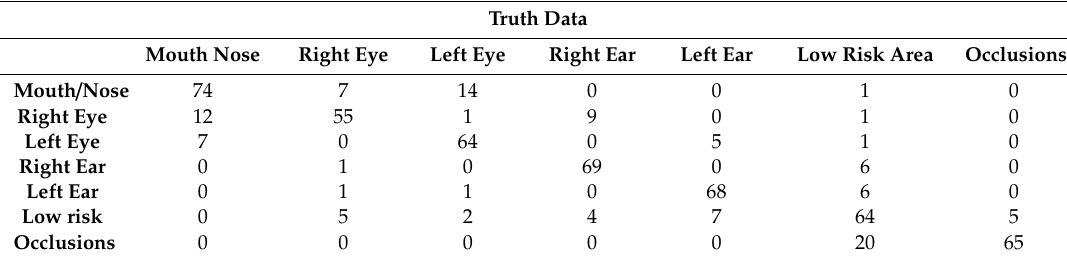
Table 1. The confusion matrix for the seven-class